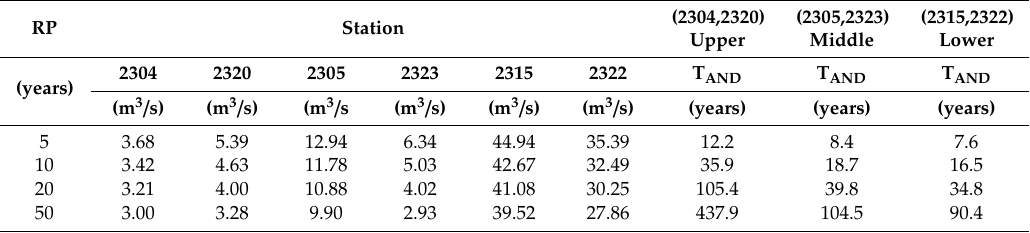
Table 5. Design values for given univariate return periods (in years) of the 7-day low-flow series at the gauge stations of interest. Additionally shown are the corresponding bivariate AND return periods estimated at the pairs of station considered in the study—see text.